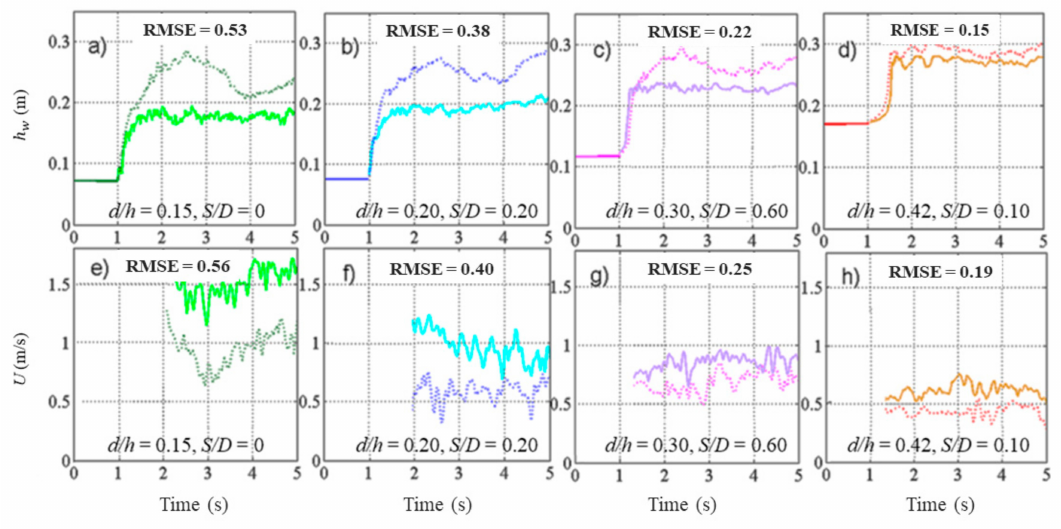
Figure 16. E ff ect of pipe presence on flow hydrodynamics, di ff erent still water depth ( d ), wet bed condition and impoundment depth, h = 40 cm, ( a ) and ( d ): d / h = 0.15, non-submerged pipe S / D = 0, ( b ) and ( f ): d / h = 0.2, less than half submerged S / D = 0.2, ( c ) and ( g ): d / h = 0.3, more than half submerged S / D = 0.6, ( d ) and ( h ): d / h = 0.425, fully submerged S / D = 1.0. (Dashed line and continuous line show